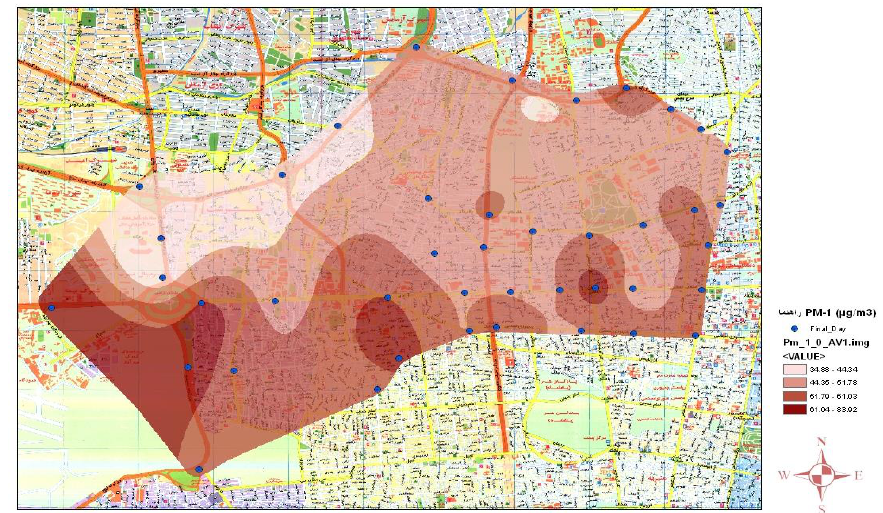
Figure 9. The distribution of mean concentration of PM 1.0 in the selected region (cold season).